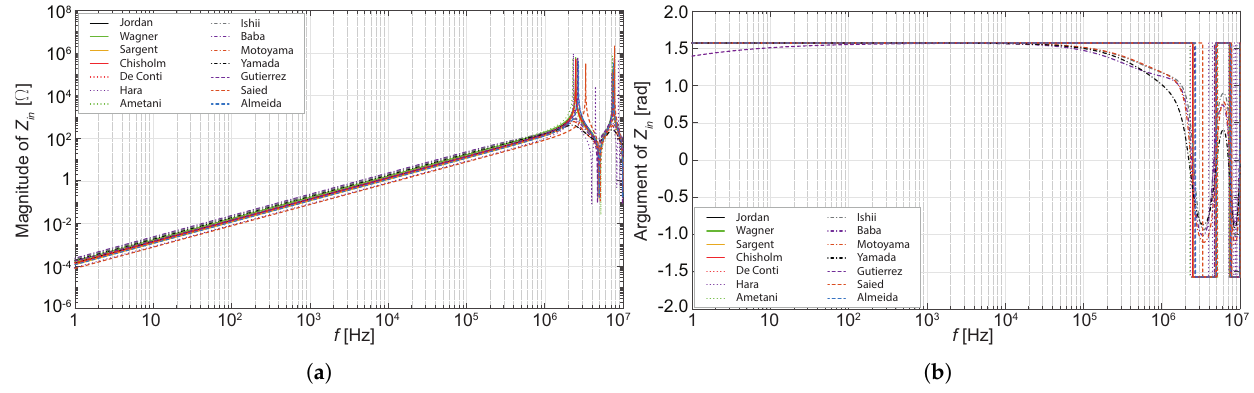
Figure 23. Input impedance Z in ( f ) seen at the top of tower (a) in Figure 16 over a PEC plane. ( a ) Magnitude of Z in ( f ) . ( b ) Argument of Z in ( f )